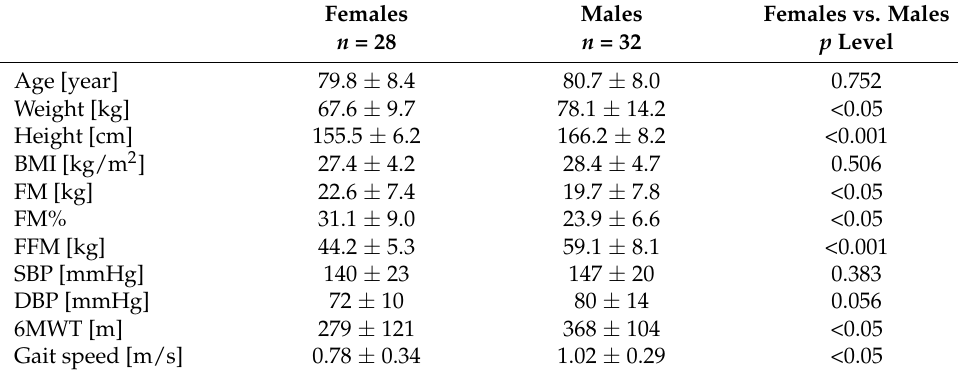
Figure 1. Study flow diagram. Table 1. Anthropometrics, body composition and physical performance (mean ± SD).